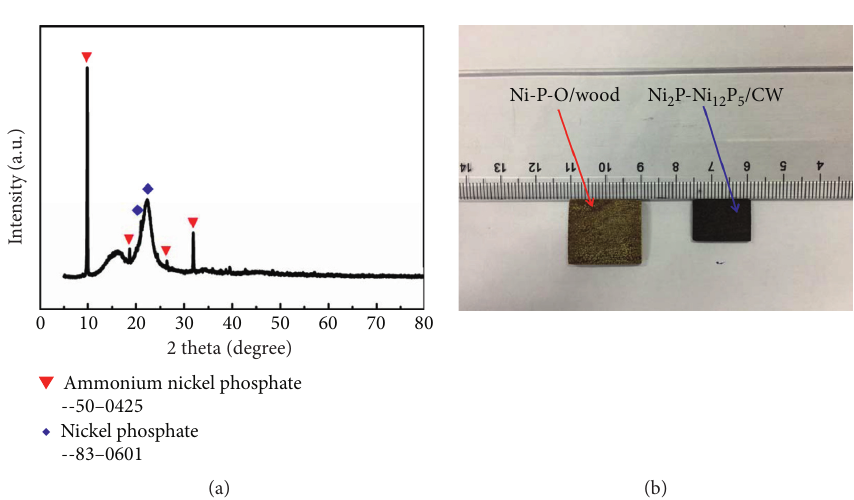
Figure 2: (a) Powder XRD pattern of the Ni-P-O precursors. (b) Digital photograph of Ni-P-O/wood and Ni